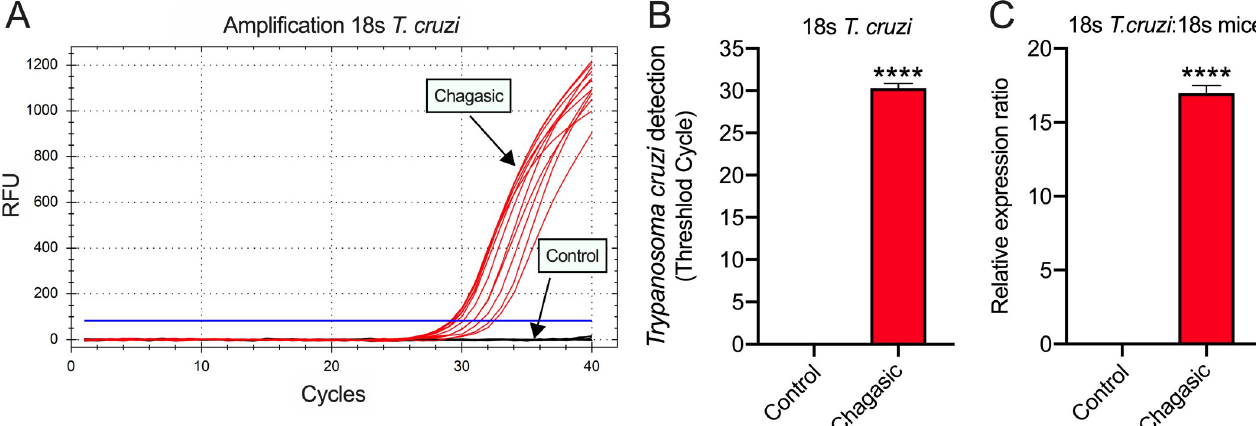
Fig 10. Detection of T . cruzi in isolated left ventricular cardiomyocytes from mice. RT-PCR analysis was performed using isolated cells obtained from mice 180 to 200 days after infection and age matched controls. The results of RT-PCR amplification of 18S T . cruzi (A), threshold cycle (B), and relative expression (C; represented as Δ Ct values) were demonstrated. Data were normalized to mice 18S endogenous (isolated left ventricular cardiomyocytes). N = 5 for both groups. Data were compared using Student’s t test. ���� p < 0.0001.